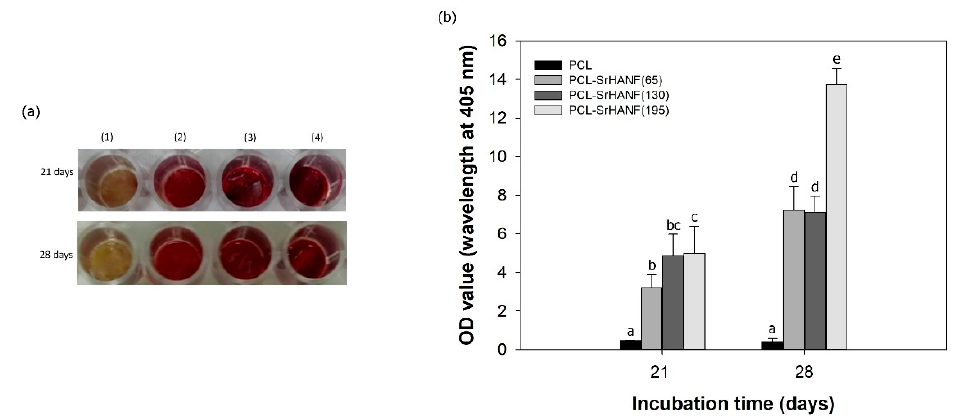
Figure 9. Immunofluorescence analysis of OCN on ( a ) PCL, ( b ) PCL–SrHANF (65), ( c ) PCL–SrHANF (130), and ( d ) PCL–SrHANF (195) after 14 days of culture. The MG63 osteoblast-like cells were stained with OCN ( red ), and the cell nuclei were stained with DAPI ( blue ). Scale bar = 50 µm.